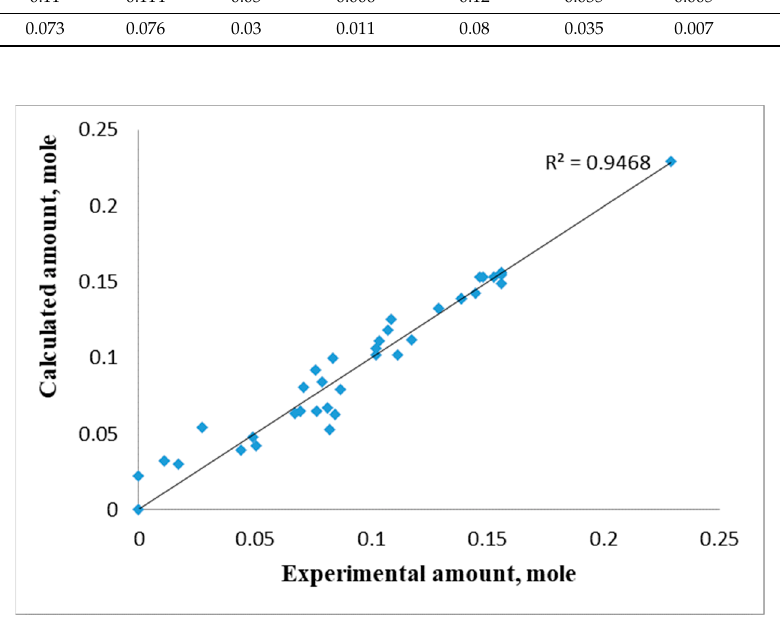
Figure 14. Correlation between calculated and experimental values.